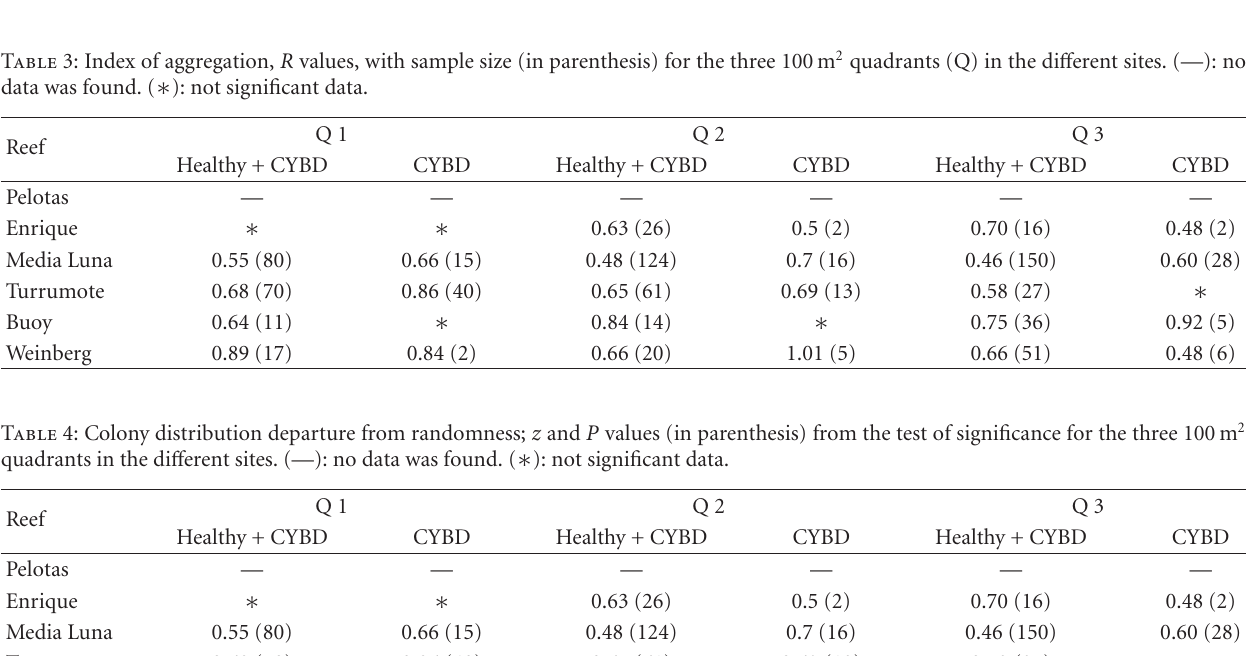
Enrique — — — 2 — 1 — — 2 — — — M. Luna — 3 — 2 2 — — Turrumote — 2 — — — Buoy — 2 — — — Weinberg — — — — — — — — 2 — — —